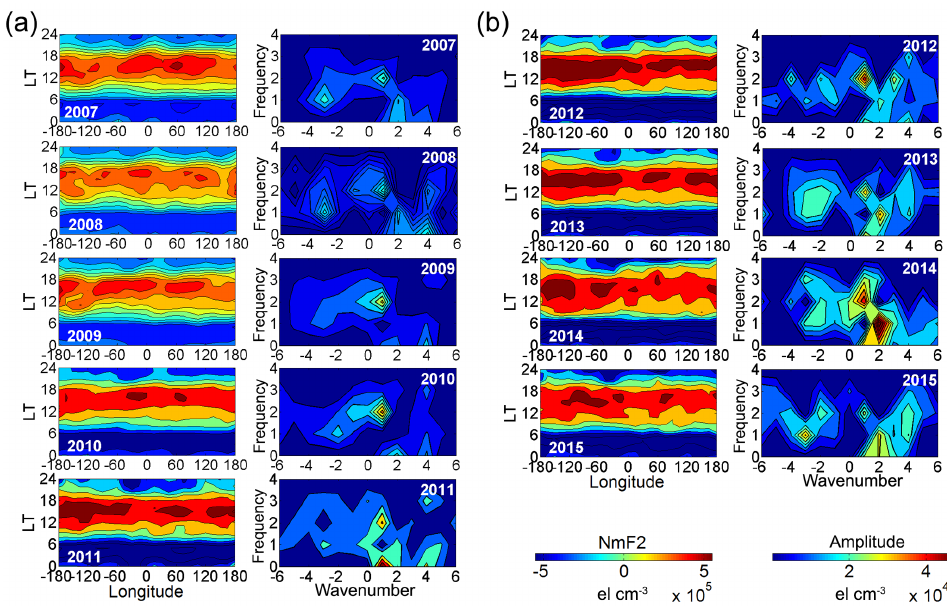
Figure 2. Nm F2 LT contour plots. (a) LT × longitude Nm F2 contour plots from 2007 to 2015 around September equinoxes. (b) Amplitudes obtained for non-migrating tides indicating their frequency (1/day) and respective zonal wavenumber. The corresponding year for each plot is indicated in the